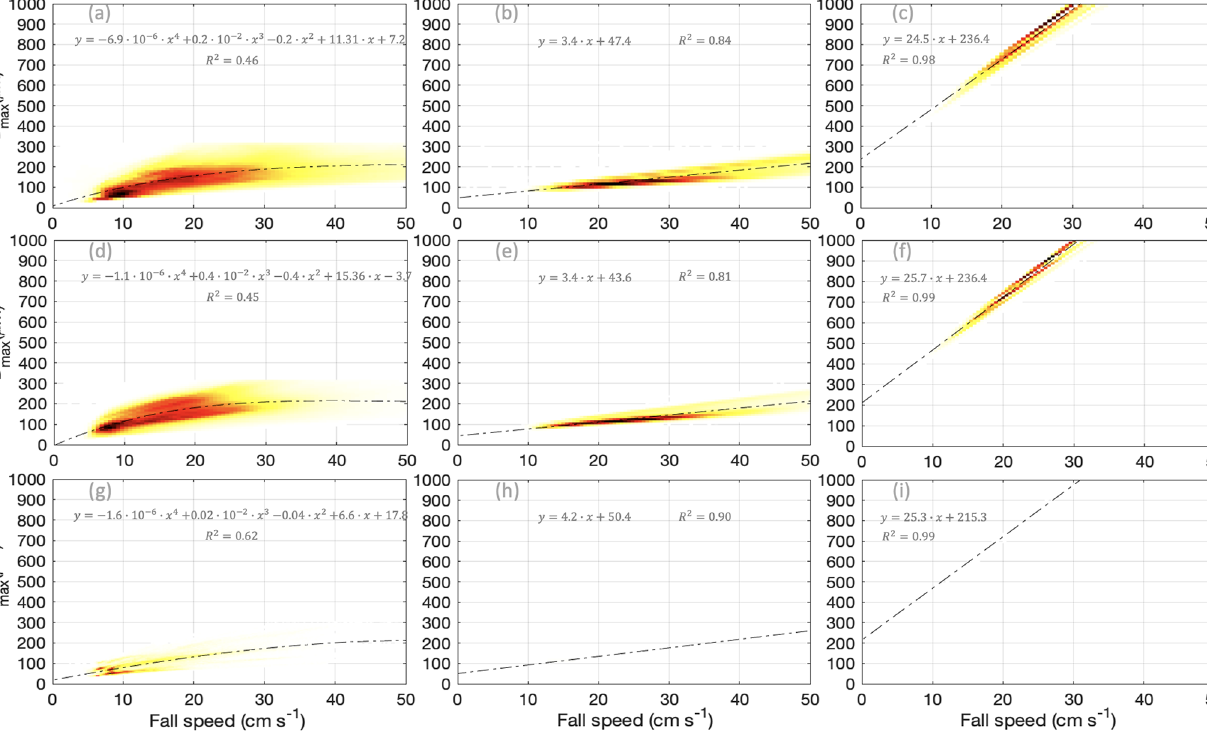
Figure 17. Density plots of maximum dimension as a function of fall speed, color coded by bin counts for three different ice habits, i.e., planar (a, d, g) , columnar (b, e, h) , and aggregate (c, f, i) , and three different regions, i.e., deep convection (a–c) , thick anvil (d–f) , and thin cirrus (g–i) . Dashed–dotted lines represent fit